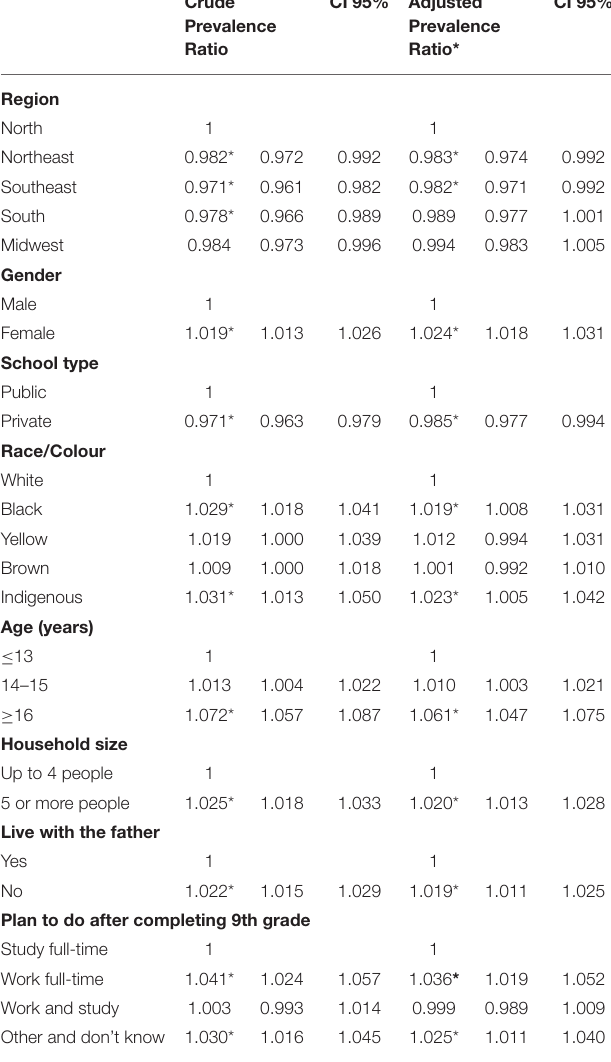
TABLE 1 | Sociodemographic characteristics according to hunger status, Brazil, 2015. Variable